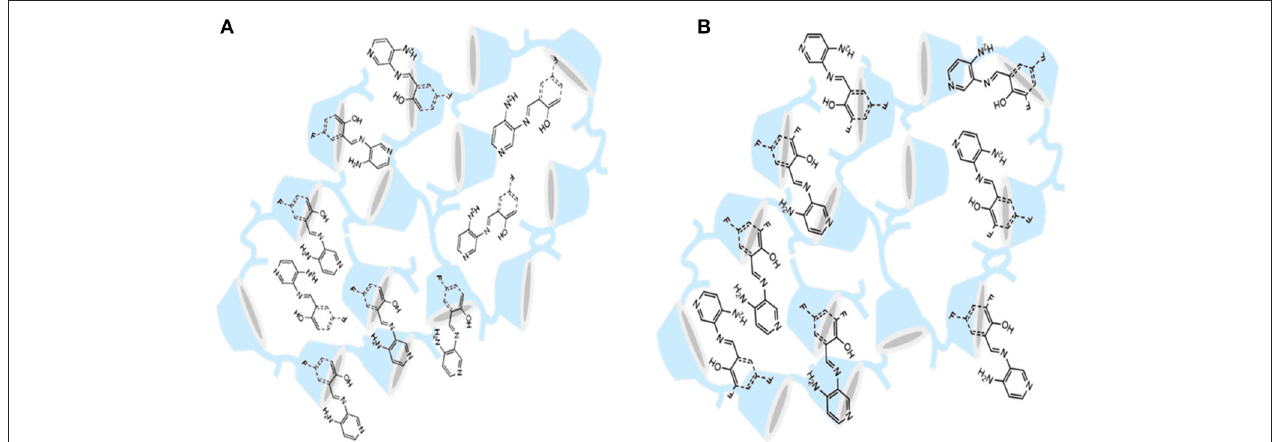
FIGURE 6 | Representation of the inclusion complex of (A) β F2 and (B) β F1 inside β CD cavity.